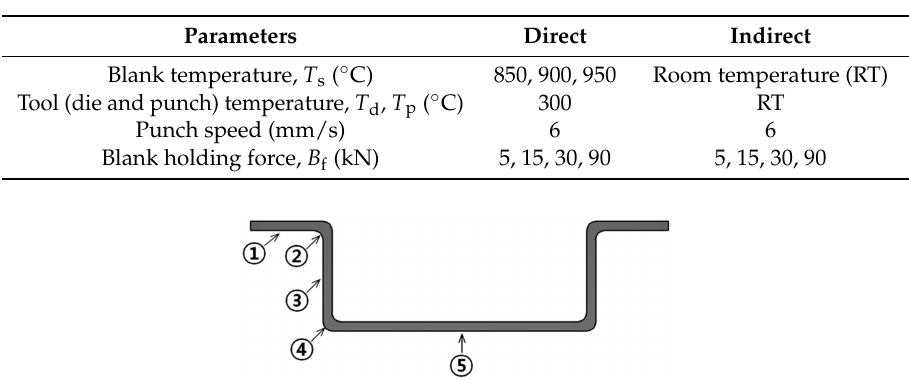
Table 2. Experiment conditions for direct and indirect hot deep drawing process.